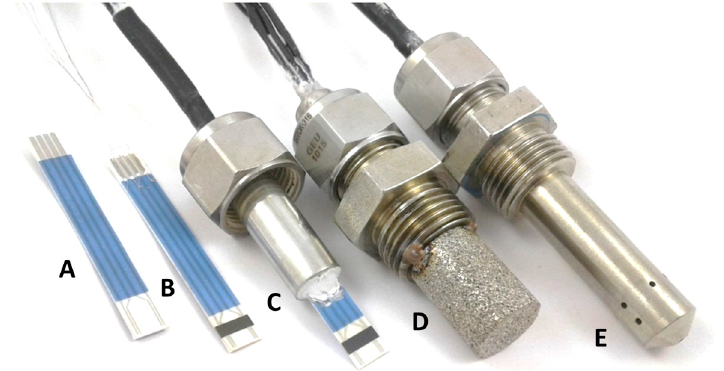
Figure 3. ( A ): Sensor element without BFT film, ( B ): with BFT film, ( C ): mounted in housing without a protection cap, ( D ): sinter metal protection cap added, ( E ): protection cap with small holes instead of a sinter metal cap.